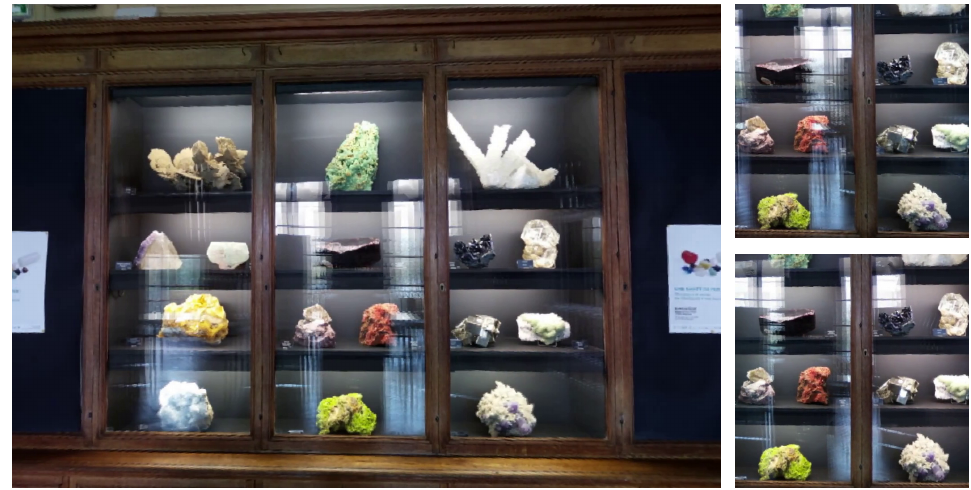
Figure 1. Rendered views from our recreated viewpoint in the MINES ParisTech Mineralogy Museum, with view-dependent reflections visible on the windows and minerals in real-time